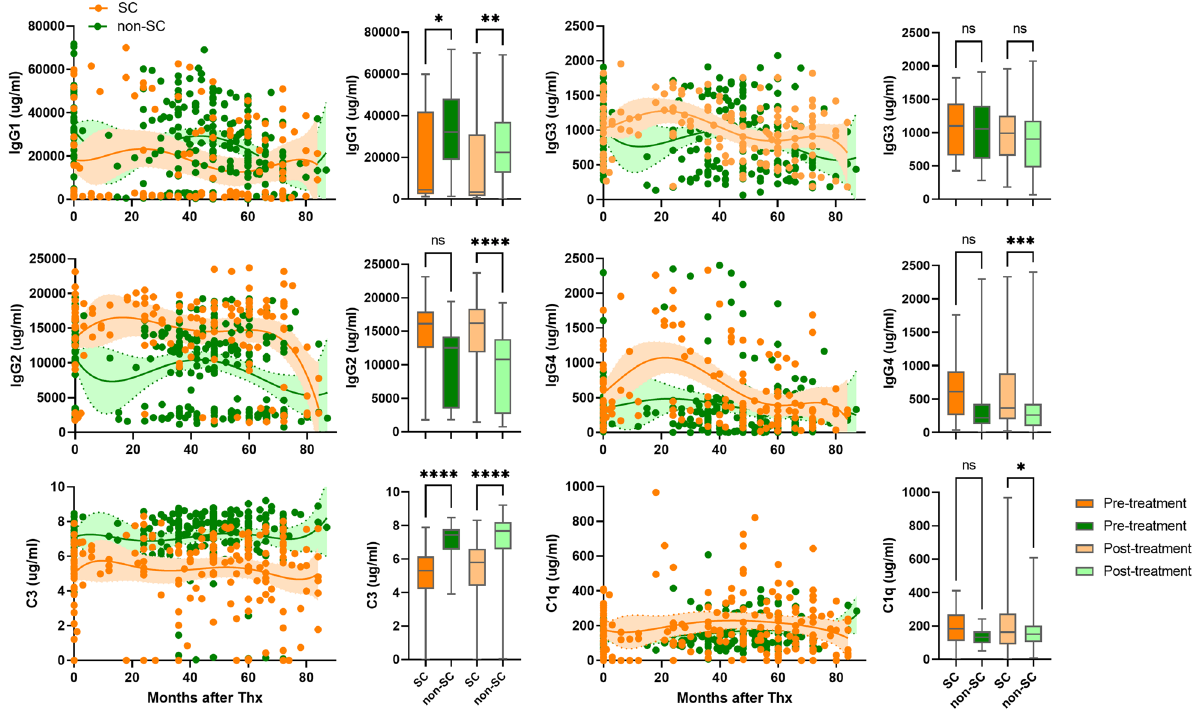
Figure 4. Levels of IgG subtypes and complement in serum of CHB patients with loss of HBeAg and detection of anti-HBe antibody, seroconversion (SC) and non-SC. Serum levels of IgG1–4, complement C3, and C1q were measured in SC patients (n = 31, orange dots) and non-SC patients (n = 45, green dots). Shaded areas indicate 95% confidence intervals around the regression lines. Bar graphs represent concentration of IgG1–4, complement C3 and C1q in pre-treatment (dark orange), post-treatment (light orange) of SC and pre-treatment (dark green), post-treatment (light green) of non-SC patients. *p ≤ 0.05, **p ≤ 0.01, ***p ≤ 0.001, ****p ≤